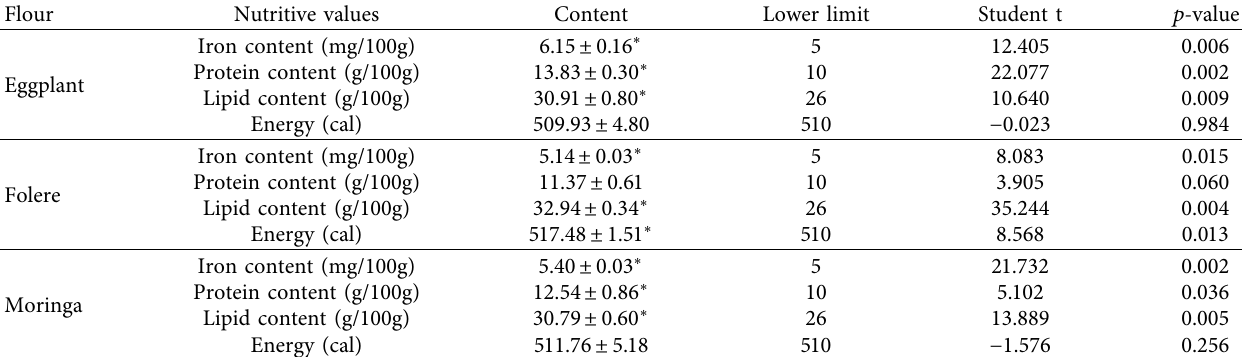
Table 3: Validation of the predicted protein, iron, lipid, and energy contents of the formulated